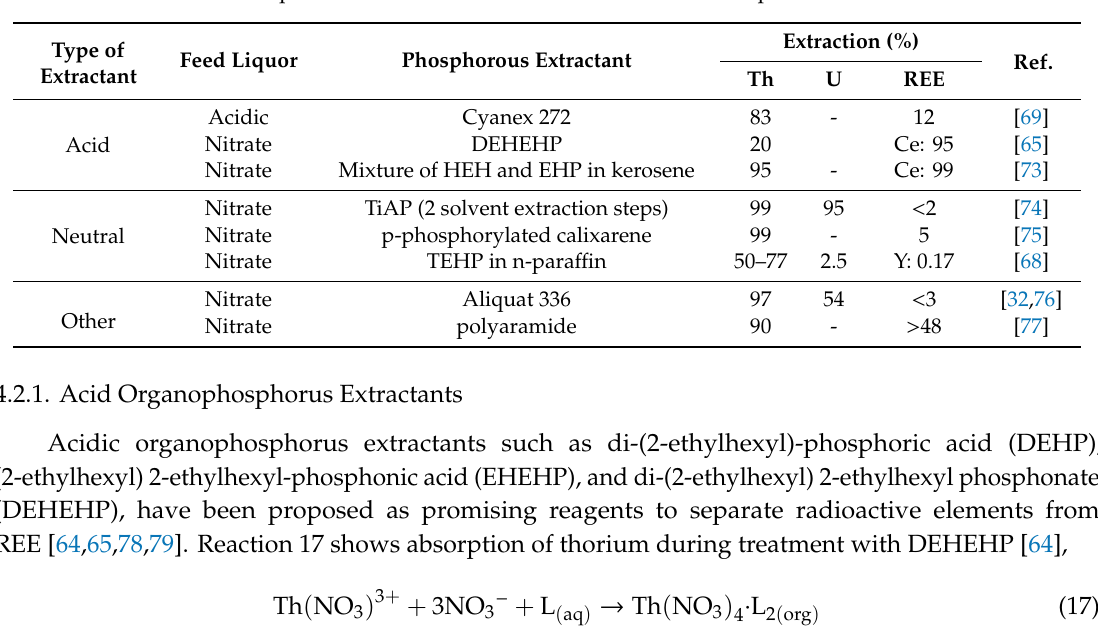
Table 6. Phosphorous extractants for uranium and thorium separation from